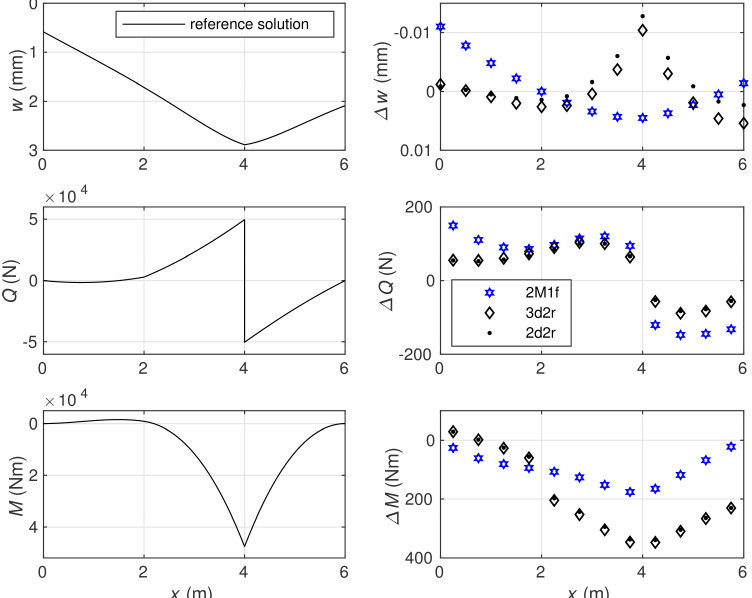
Figure 14. The reference solution: the deflection, shear force and bending moment ( left diagrams ); comparison of these quantities obtained with 12 element meshes with the reference solution: for 2M1f, 3d2r and 2d2r models ( right diagrams ). K s = 0.2 · 10 9